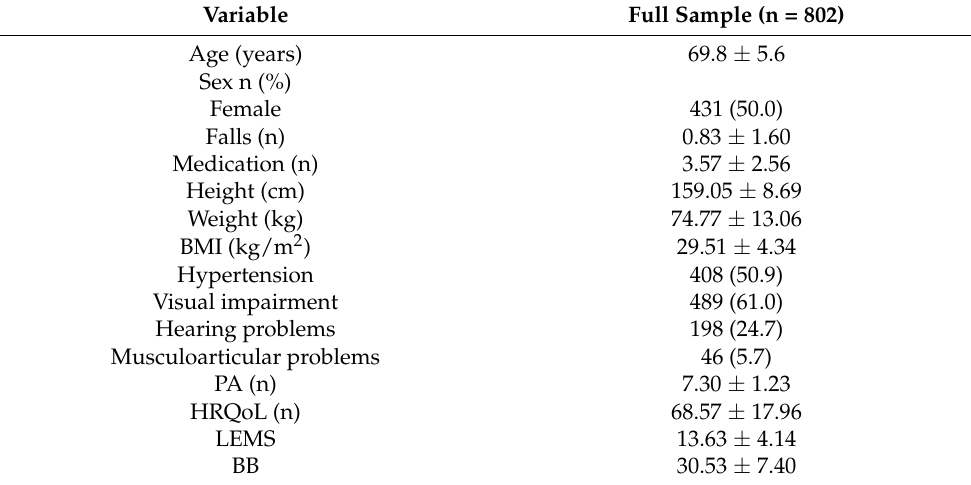
Table 1. Main characteristics of the